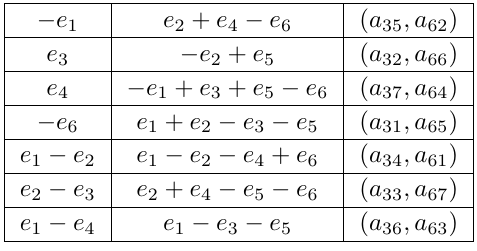
Table 2 . Dimension-2 faces that are missing in F 4 ; 7 compared to the E 6 cluster fan. In the (cid:12)rst two columns, the two rays spanning the face are given. In the (cid:12)nal column we state the cluster variables associated to these